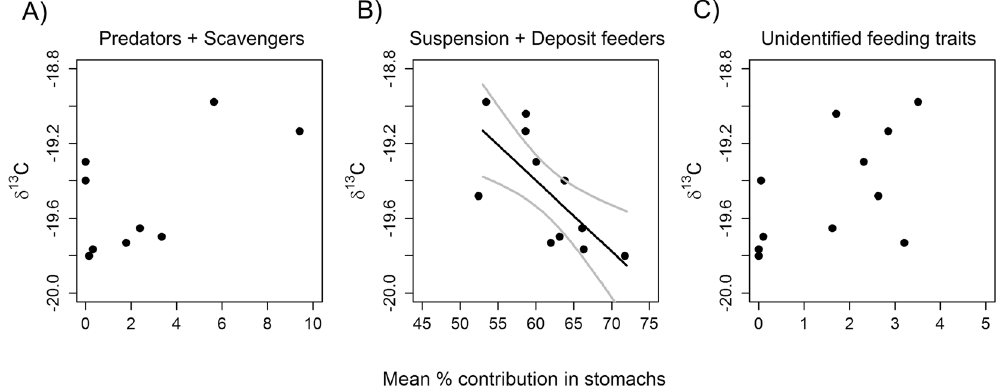
Figure 5. Plaice stomach composition of functional feeding groups along the trawling gradient in the Kattegat. Relationship between mean percentage contribution in weight in plaice stomach of ( A ) Predators and Scavengers, ( B ) Suspension + Deposit feeders, and ( C ) Unidentified feeding traits and δ 13